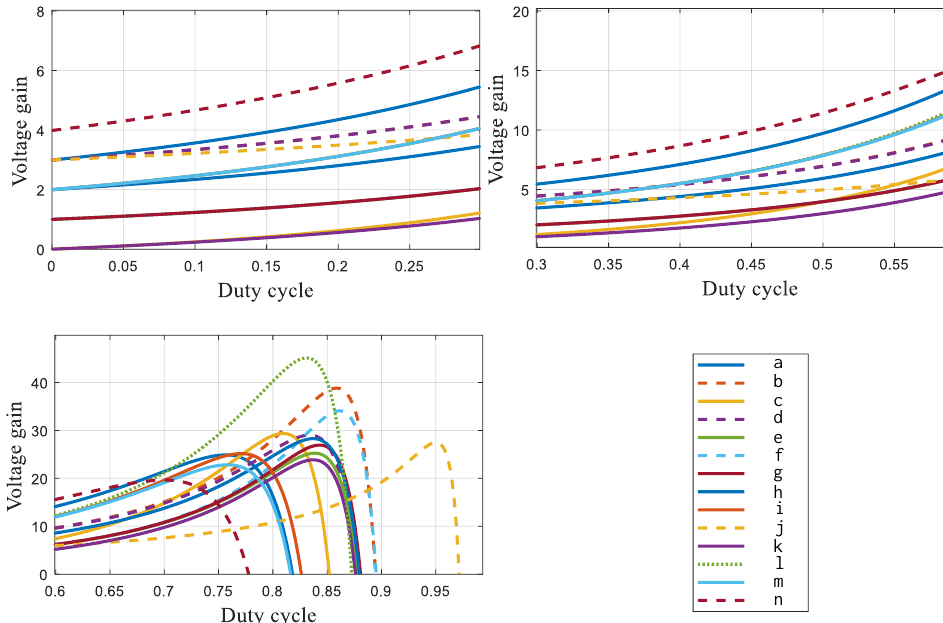
Figure 8. The comparison of the voltage gain: (a) proposed converter, (b) introduced topology in [18], (c) introduced topology in [19], (d) introduced topology in [20], (e) introduced topology in [21], (f) introduced topology in [22], (g) introduced topology in [23], (h) introduced topology in [24], (i) introduced topology in [25], (j) introduced topology in [26], (k) introduced topology in [27], (l) introduced topology in [28], (m) introduced topology in [29],(n) introduced topology in